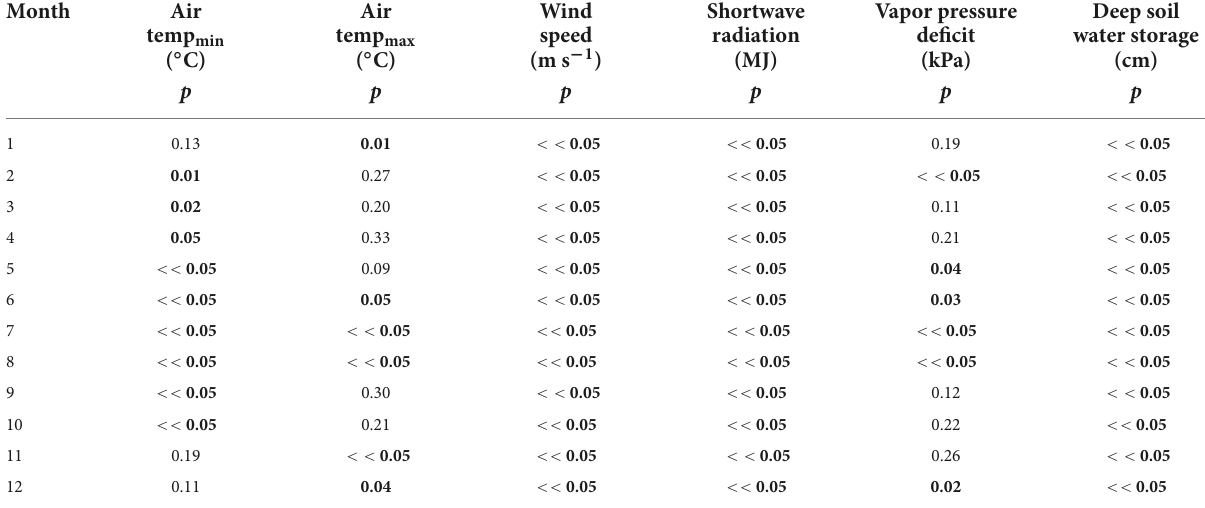
TABLE 2 Kruskal–Wallis p value among monitoring sites, significant at 0.05